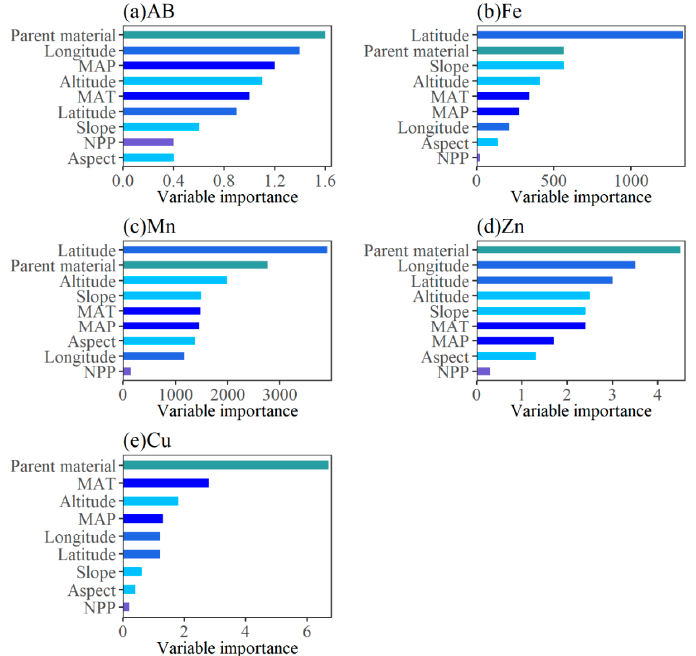
Figure 4. Variable importance of predictors in forecasting soil physicochemical properties. (MAT indicates mean annual temperature, MAP indicates mean annual precipitation, NPP indicates net primary productivity). ( a ) AB indicates soil available boron concentration; ( b ) Fe indicates soil iron concentration; ( c ) Mn indicates soil manganese concentration; ( d ) Zn indicates soil zinc concentration; ( e ) Cu indicates soil copper concentration.